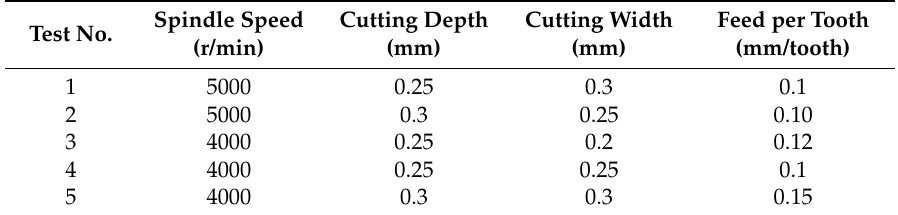
Figure 8. Ball-end milling cutters with different wear states ( a ) VB = 0; ( b ) VB = 87um; ( c ) VB = 121 um; ( d ) VB = 164 um. VB—the tool wear. Table 1. The experimental scheme.